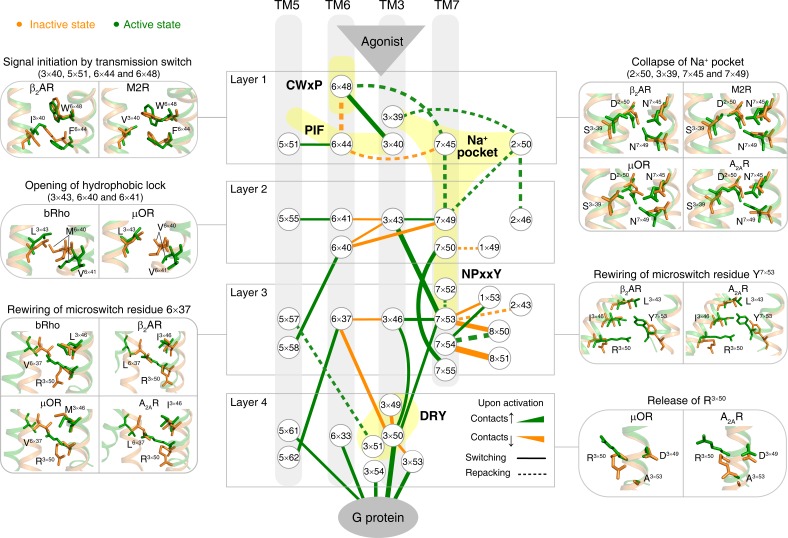
Common activation pathway of class A GPCRs.Node represents structurally equivalent residue with the GPCRdb numbering (Isberg et al., 2016) while the width of edge is proportional to the average ∆RRCS among six receptors (bRho, β2AR, M2R, µOR, A2AR and κ-OR). Four layers were qualitatively defined based on the topology of the pathway and their roles in activation: signal initiation (layer 1), signal propagation (layer 2), microswitches rewiring (layer 3) and G-protein coupling (layer 4).